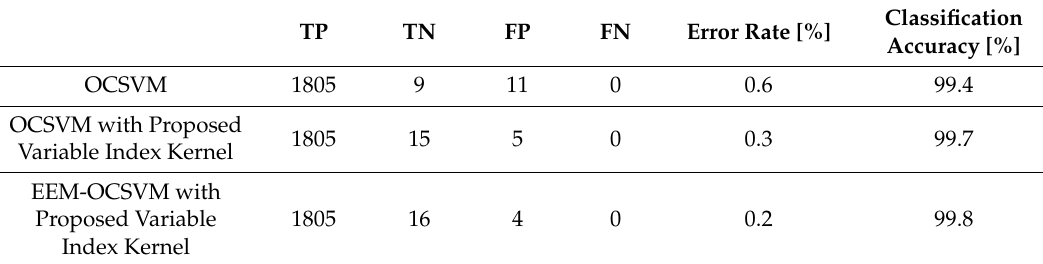
Table 6. The classification accuracy of OCSVM, OCSVM with the proposed variable index of the linear kernel, EEM-OCSVM with the proposed variable index of the linear kernel (5 years of daily data, 1825 data